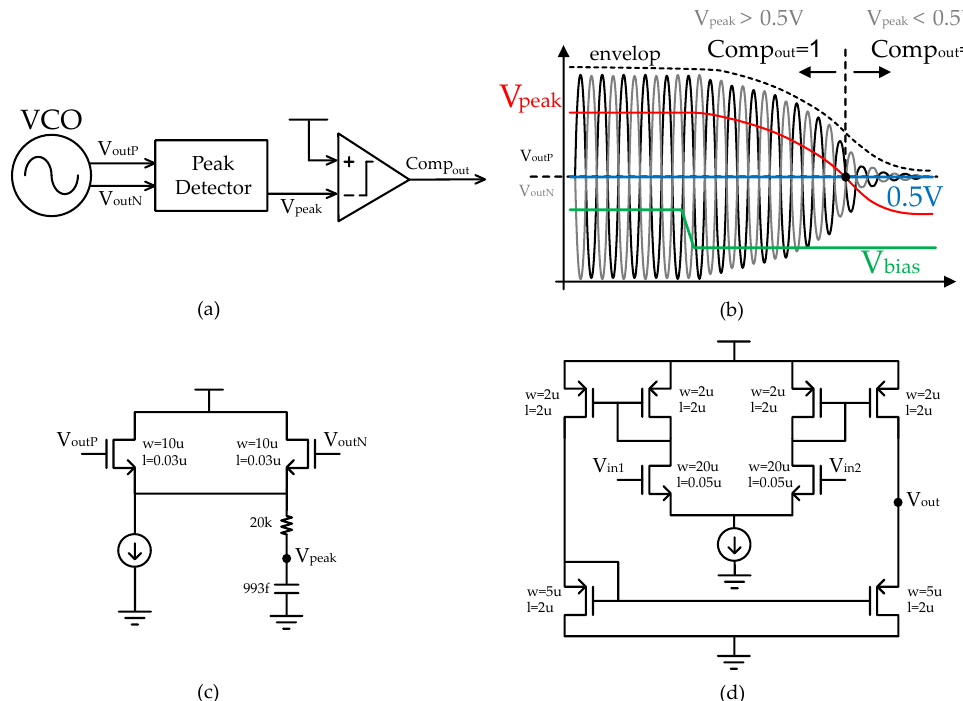
Figure 9. ( a ) Block diagram of OFF detection circuit, ( b ) its transient response detecting the OFF state of the oscillator, ( c ) structure of peak detector, and ( d )